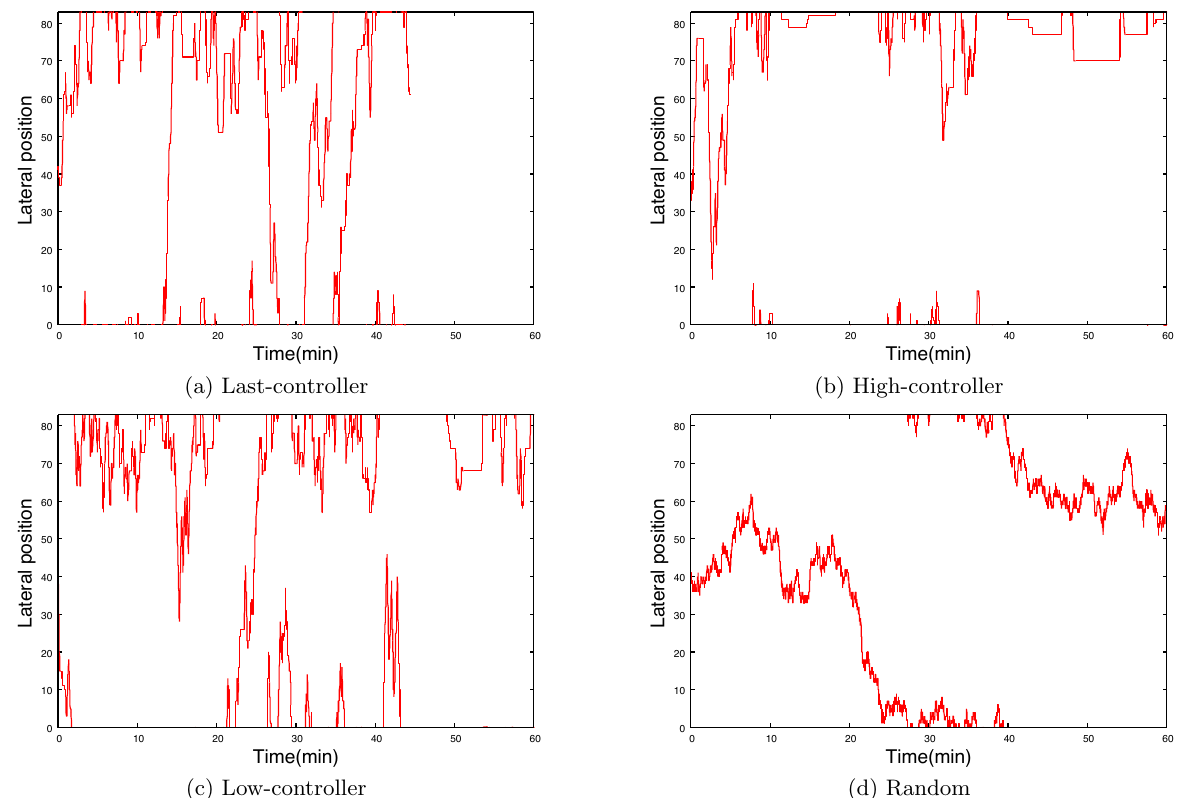
Figure 6: White dot movements in the lateral